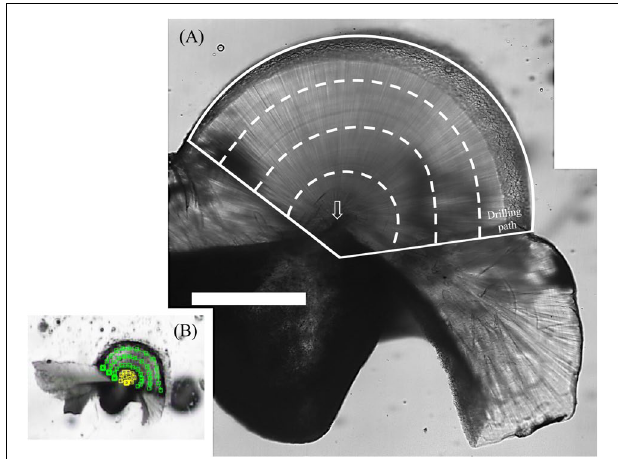
FIGURE 2 | Polished S. lessoniana statolith (K180116012) with the drilling paths for powder collection. (A) White solid lines indicate the entire powder collection area at the lateral dome region and dashed lines indicate approximate boundaries of the drilling path. Arrow indicates the statolith core. Scale bar = 400 µ m. (B) The setting of the drilling path. Yellow and green lines indicate the paths of drill tip at the core and the outers of the core, respectively, square as a turning point. The intervals between lines are 150–190 µ m.